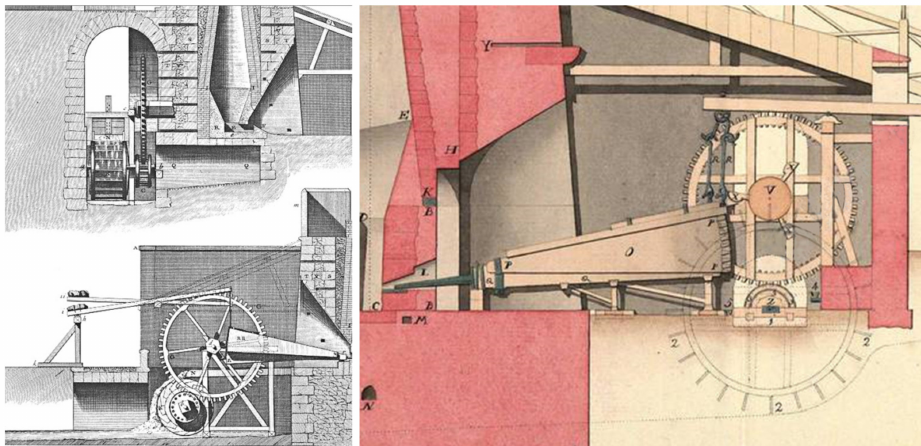
Figure 9. Gears and bellows according to Diderot (1756) [53] and Del Rey (1771)